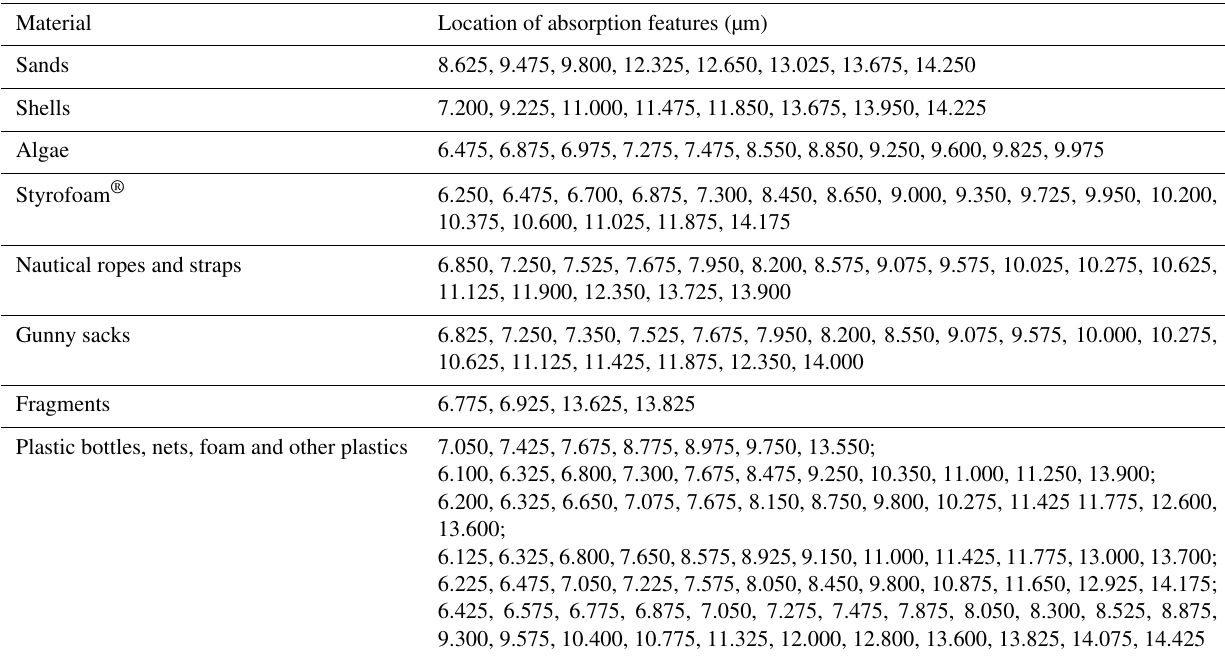
Table 1. Location of proposed diagnostic absorption features derived from spectral measurements of samples from the shorelines of Punta Mallil-Cuem, Detif and Punta Apabón on the Chiloé Archipelago,